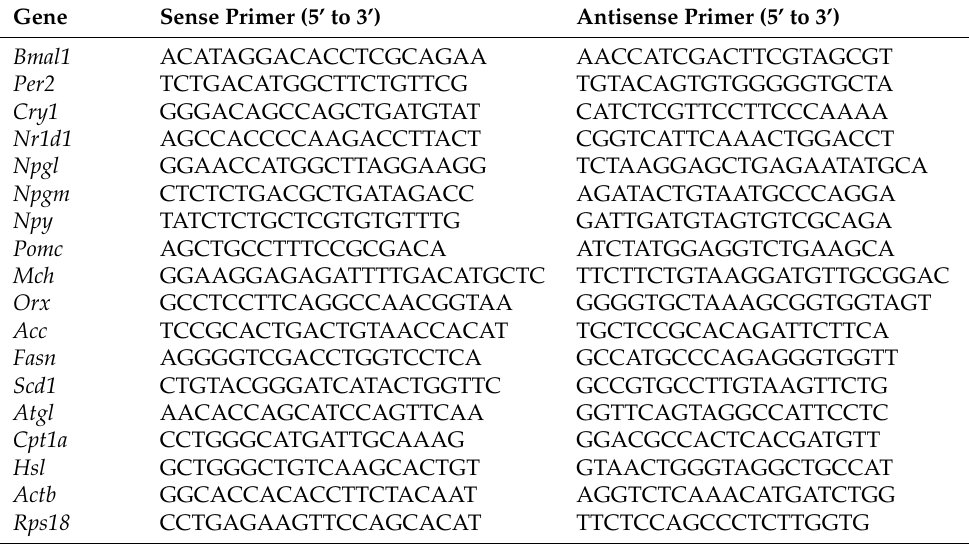
Table 4. Sequences of oligonucleotide primers for quantitative